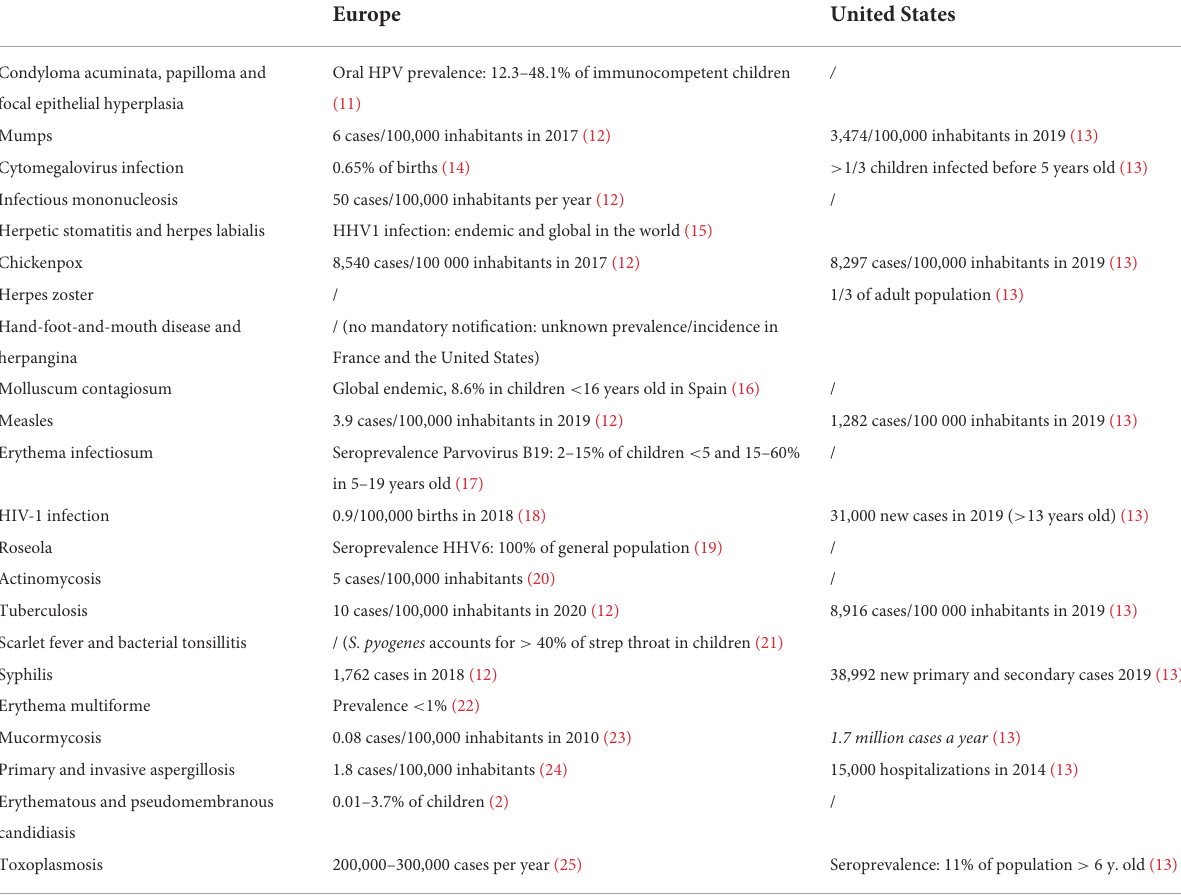
TABLE 1 Epidemiological data in the general population for the 28 diseases included in the decision tree (HPV, human papillomavirus; /, no data available; HHV, human herpesvirus). Europe United